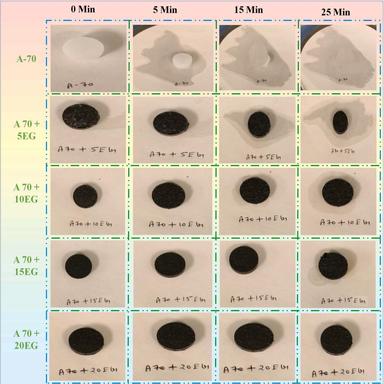
Schematic diagram of leakage test of A70 and the SS-PCM composite samples.